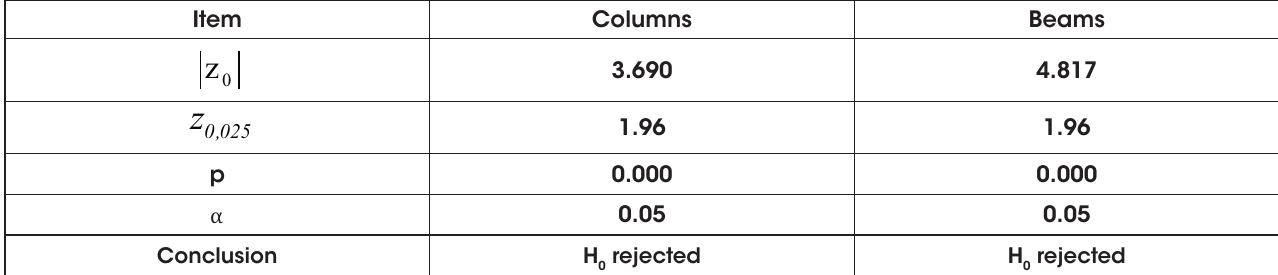
Table 7 Results of Mann-Whitney test for columns and beams (verifying differences per “symmetric” x “non-symmetric”